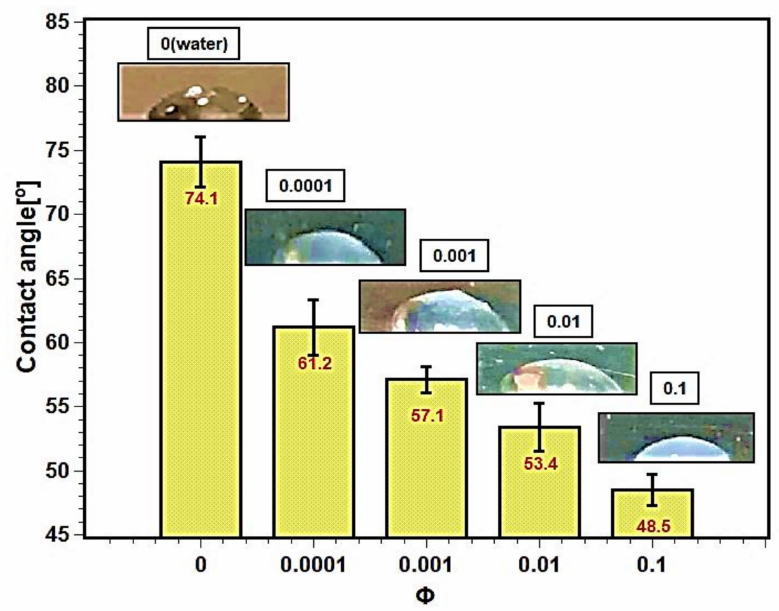
Figure 14. Surface contact angles for silica–water nanofluids at different